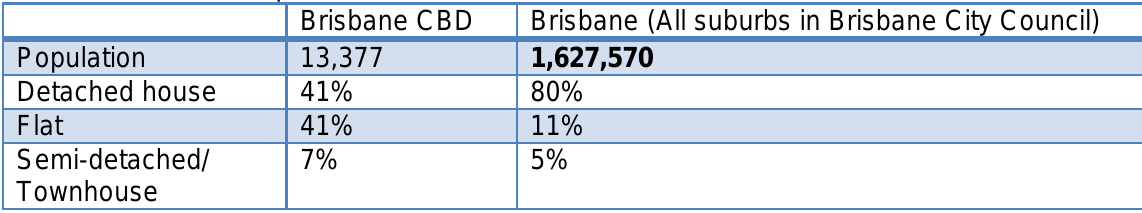
Table 1: 2011 Suburb profiles for